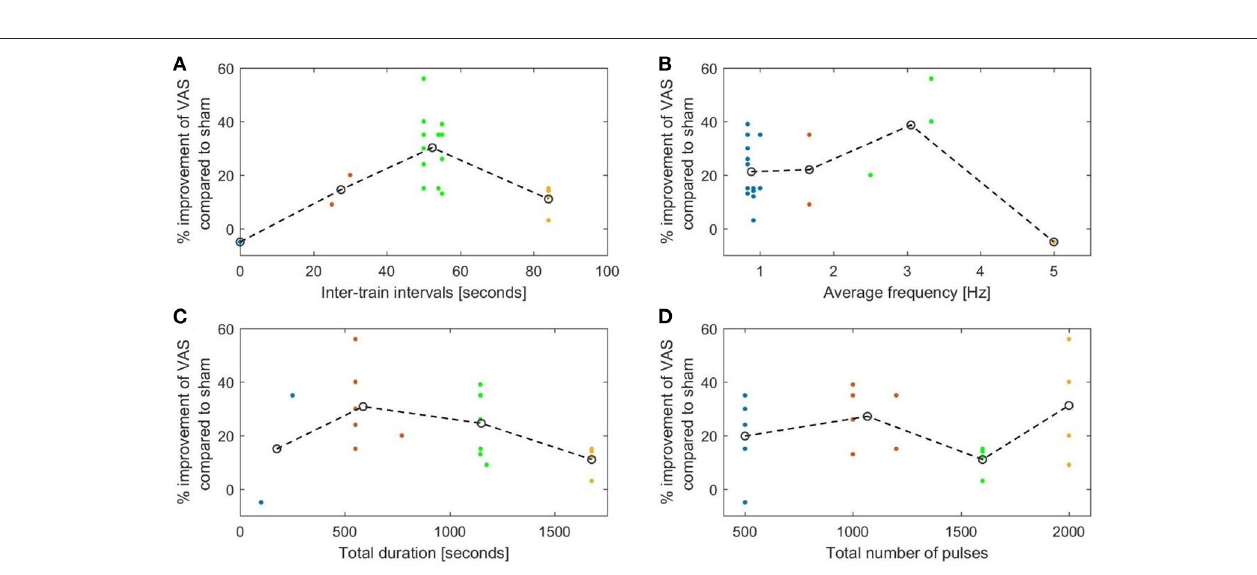
FIGURE 6 | The percentage decrease in VAS rated pain compared to sham plotted against. (A) The duration of the inter-stimulation intervals ( R 2 = 0.53). (B) The length of the average stimulation frequency ( R 2 = 0.36). (C) The total duration of stimulation ( R 2 = 0.33). (D) The total number of pulses ( R 2 = 0.24).